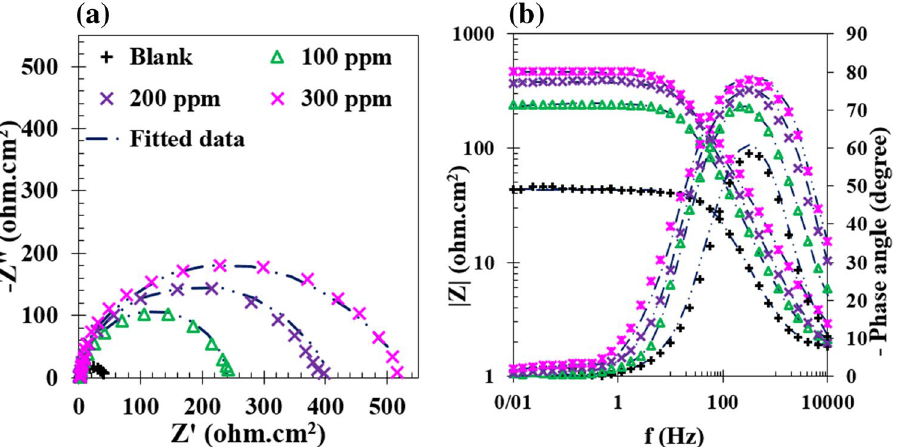
Figure 2. The Nyquist ( a ) and Bode ( b ) diagrams of MS samples immersed in 1 M HCl solution at different concentrations of GSE at 25